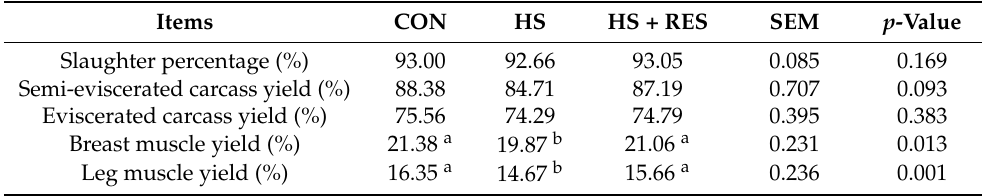
Table 2. Effects of RES on the carcass traits of heat-stressed